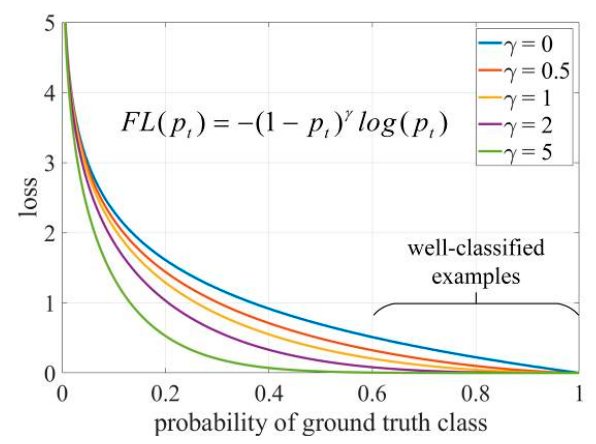
Figure 6. Focal Loss Functions.